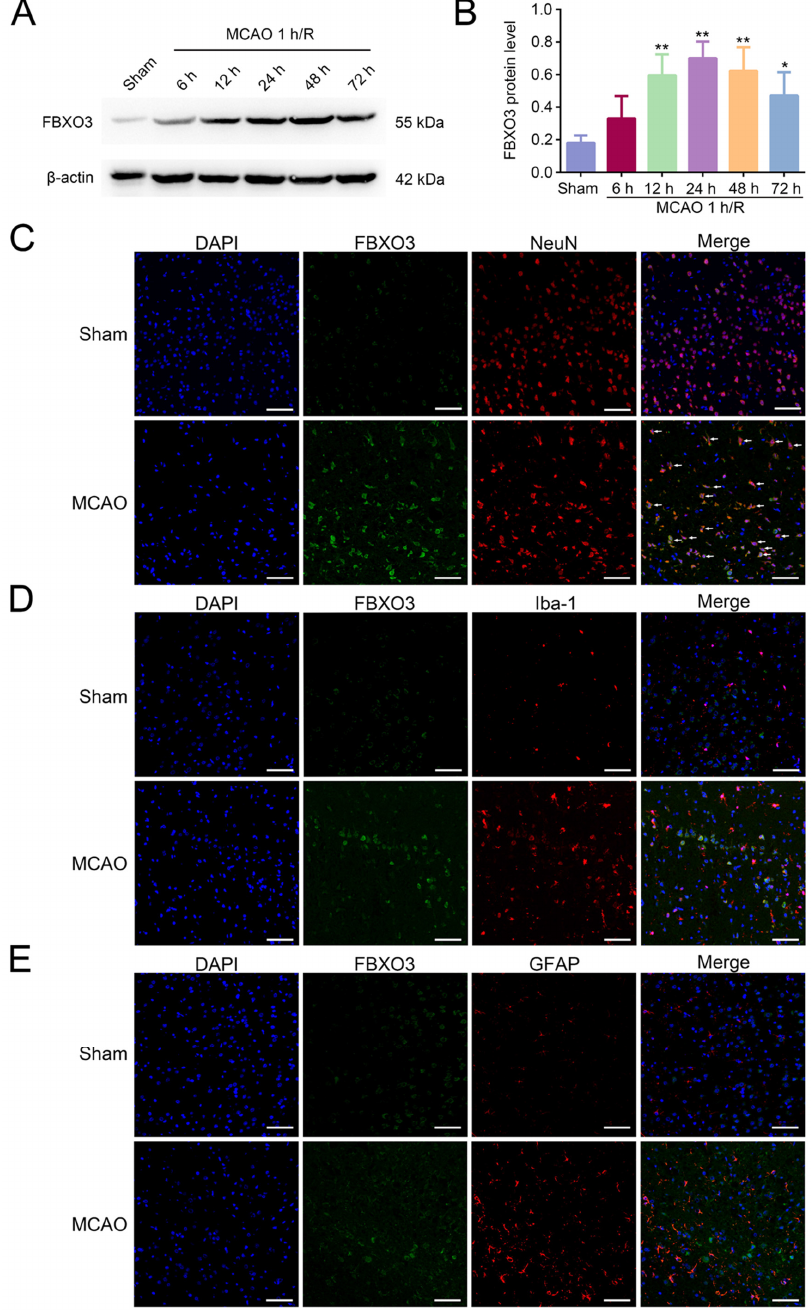
Figure 1. FBXO3 was elevated after Middle cerebral artery occlusion/reperfusion (MCAO/R) in Sprague-Dawley (SD) rats, and specifically expressed in neurons. ( A , B ) Western blotting (WB)